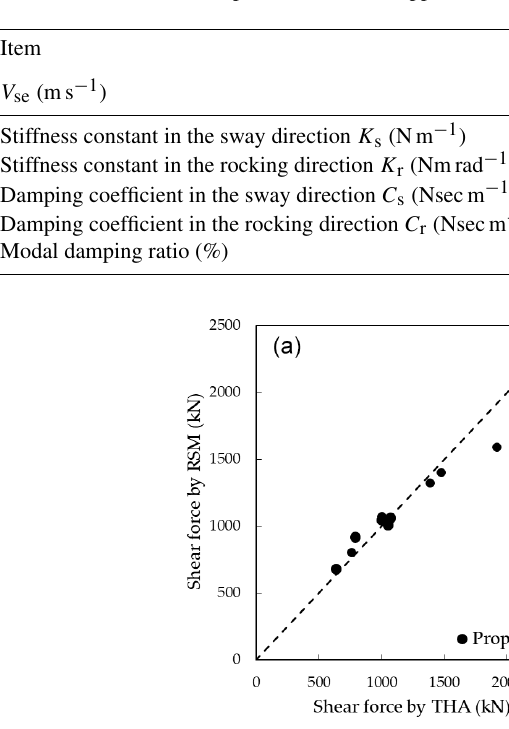
Figure 9. The comparison of seismic loadings on the tower by the proposed method and THA: (a) shear forces and (b) bending